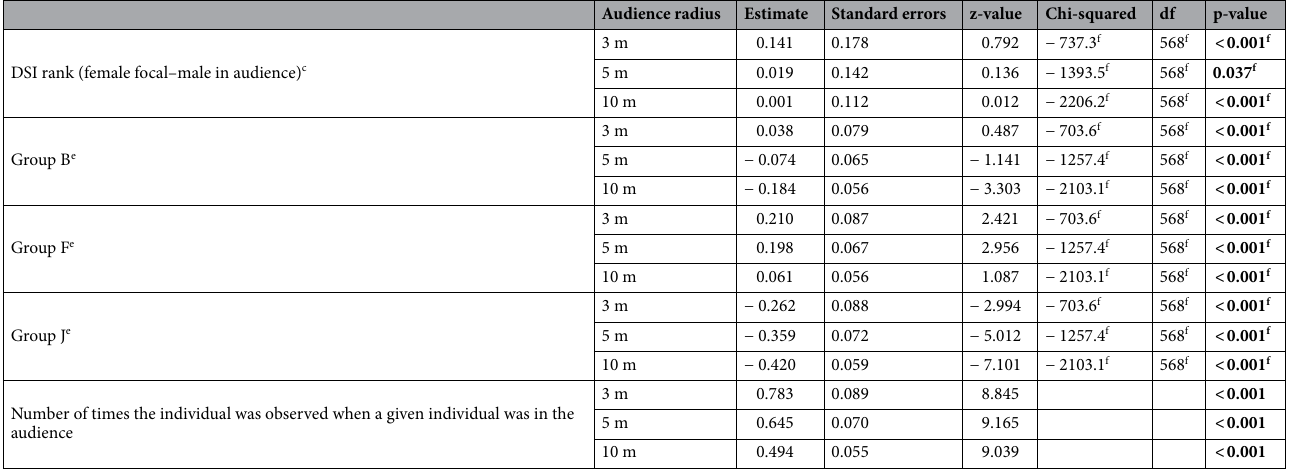
Table 3. Results of the exponential graph model of the effects of audience composition within 3, 5 and 10 m radius on the probability that an individual scent-mark when passing a marking spot. Significant p-values are in bold. a Not shown because of having a very limited interpretation. b Comparisons with the reference level (male sub-adult). c Comparisons with the reference level (male focal–male in audience). d Comparisons with the reference level (male in the audience). e Comparisons with the reference level (Group A). f Value corresponding to the full-reduced model